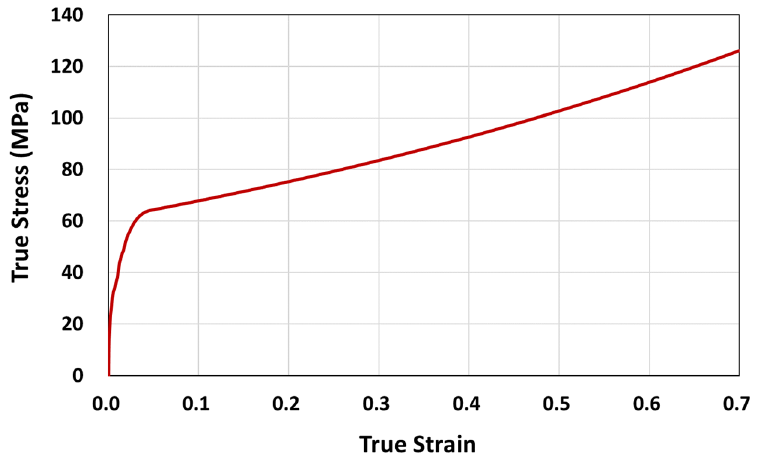
Figure 15. True stress–strain curve for PC.